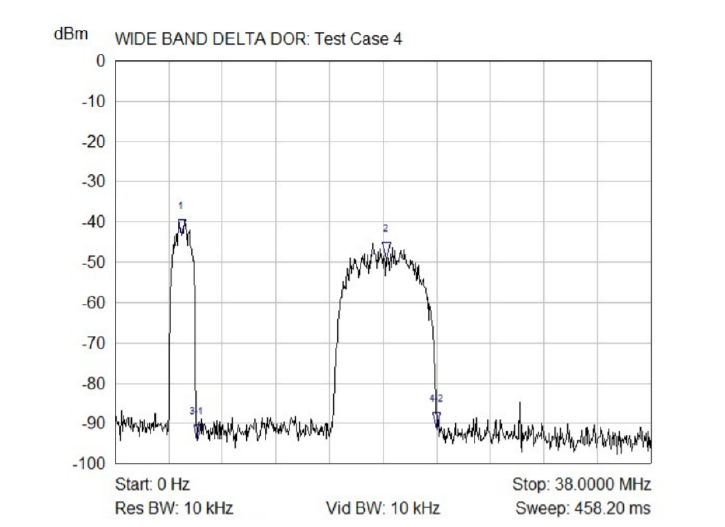
Figure 8. Test case 4 measured.